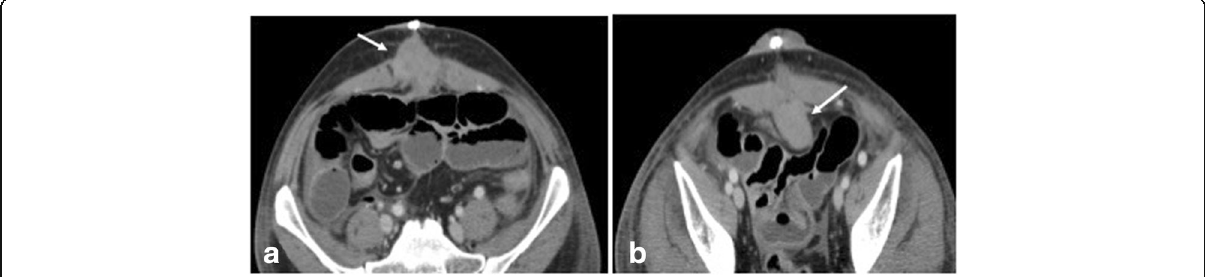
Fig. 6 a CECT in axial section shows hyperdense parietal wall hematoma (arrow) in a patient with post open ventral hernia repair. b CECT axial section at inferior level shows preperitoneal extension of the hematoma